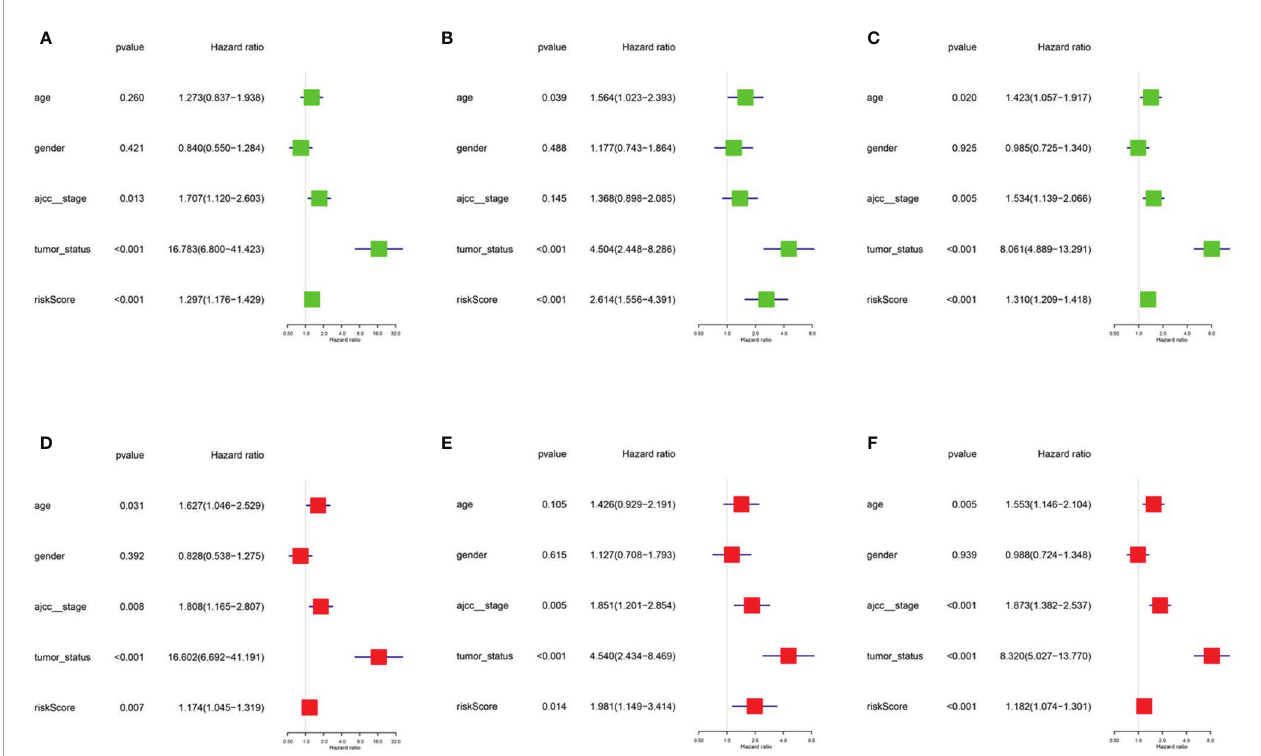
FIGURE 5 | Univariate model and multivariate model of the training, testing and entire cohort. (A) Univariate model of training cohort. (B) Univariate model of testing cohort (C) Univariate model of entire cohort (D) multivariate model of training cohort (E) multivariate model of testing cohort (F) multivariate model of entire